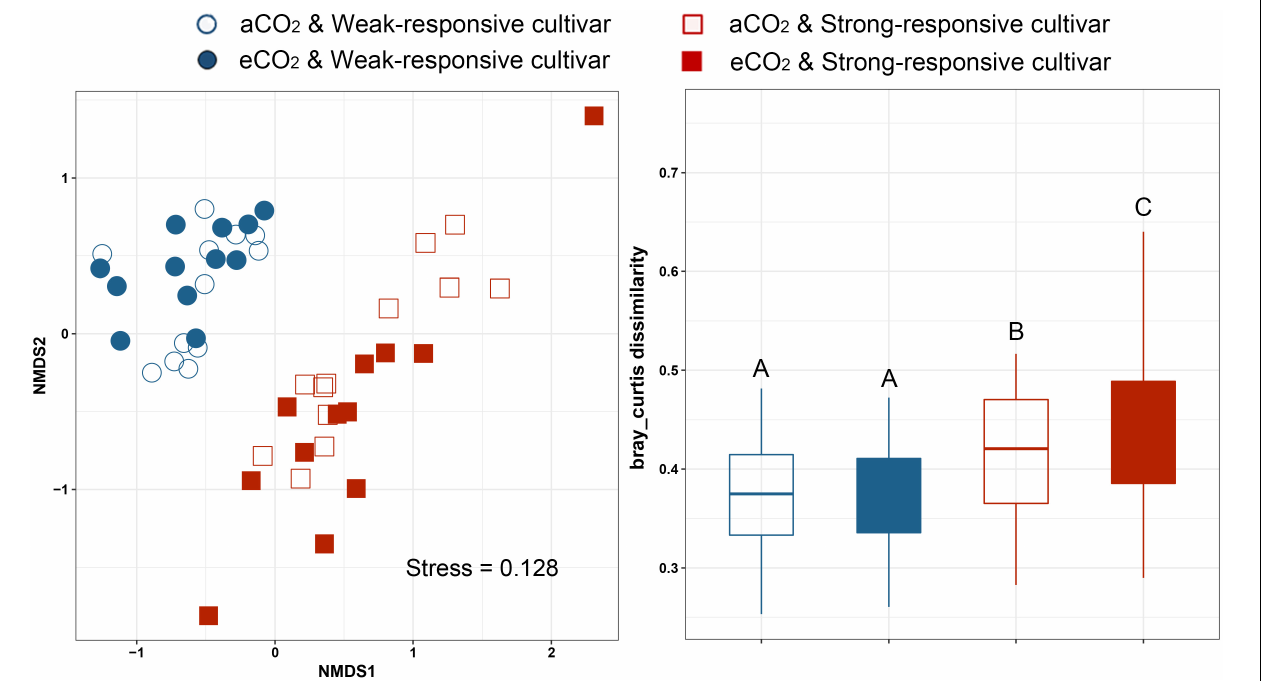
FIGURE 2 | Non-metric multidimensional analysis of community dissimilarities within different groups basing on Bray-Curtis distance. (A) NMDS plot; (B) box plots based on dissimilarity of diazotrophic communities under different treatments.